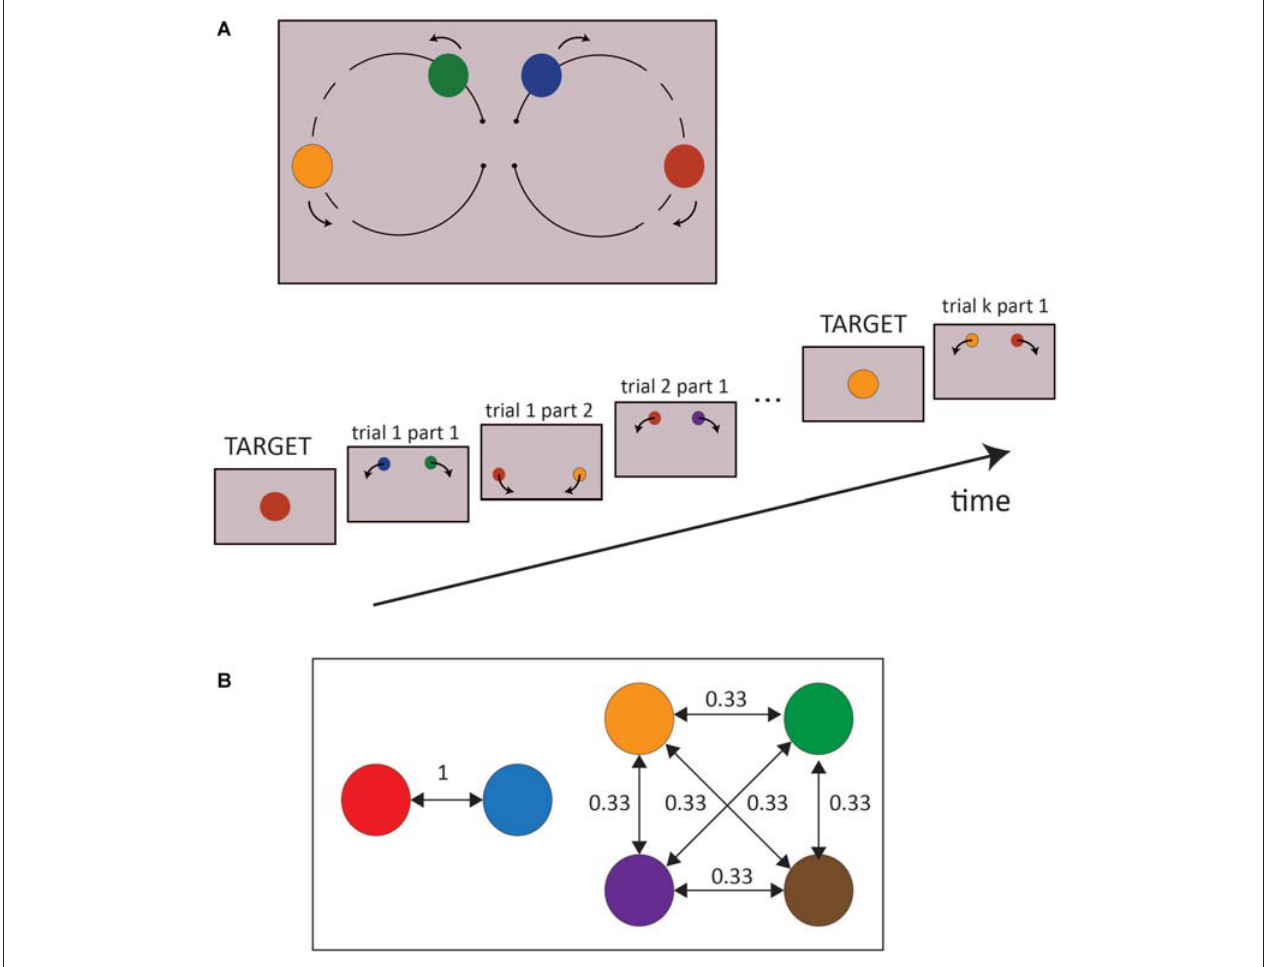
FIGURE 1 | (A) Experimental Design. The upper part is a schematic representation of a whole trial, while the lower part of the picture represents the successive stages of a block. The dashed line represents the range of dot positions in which a change of color may occur. (B) An example of transition probabilities between colors is represented. Two colors were always associated to each other (conditional probability = 1, predictable colors) while the remaining colors all shared a conditional probability equal to 0.33 (unpredictable colors). The transition probabilities of the colors were pseudo randomized between subjects.